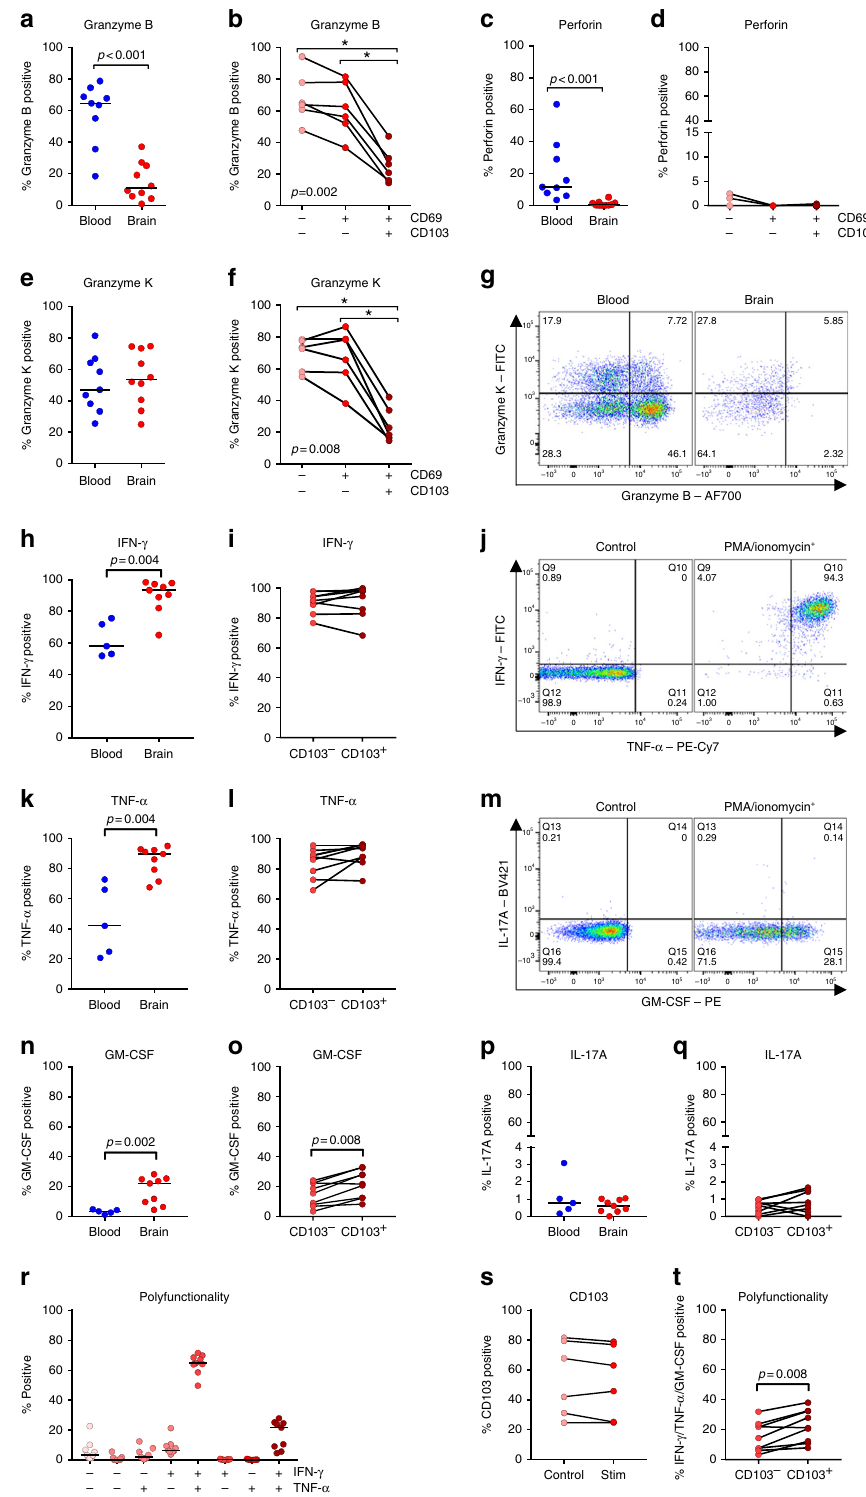
Fig. 6 CD103 + brain CD8 + T cells express few cytolytic enzymes but show a polyfunctional cytokine pro fi le. a – f Quanti fi cation of the percentage of brain CD8 + T cells directly ex situ expressing granzyme B, perforin, and granzyme K, respectively. g Representative dot plots of CD3 + CD8 + T cells stained for granzyme B and granzyme K. h – i , k – l , n – q Quanti fi cation of the percentage of brain CD8 + T cells positive for IFN- γ , TNF- α , GM-CSF, and IL-17A